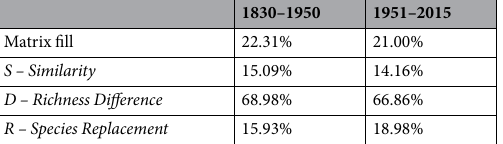
Table 3. Results of the Simplex SDR analyses for all pairwise (n = 120) comparisons of the 16 islands of the Tuscan archipelago in the two study periods.